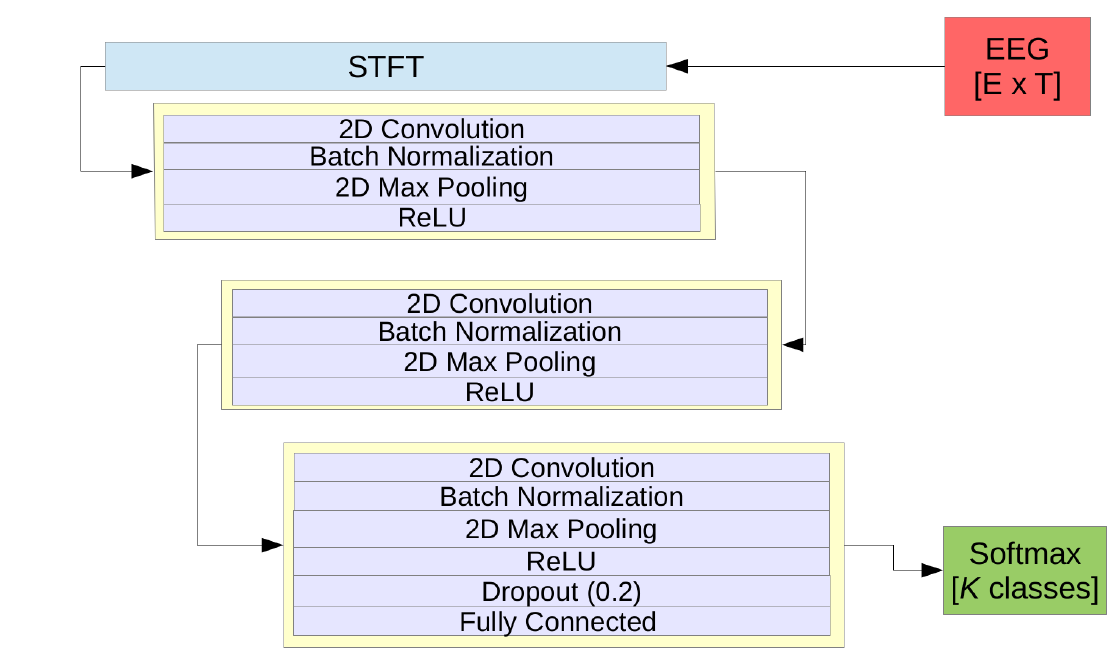
Figure 3. The pragmatic conventional neural network (pCNN) model’s architecture, where E is the number of electrodes, T is the number of timesteps, and K is the number of classes.